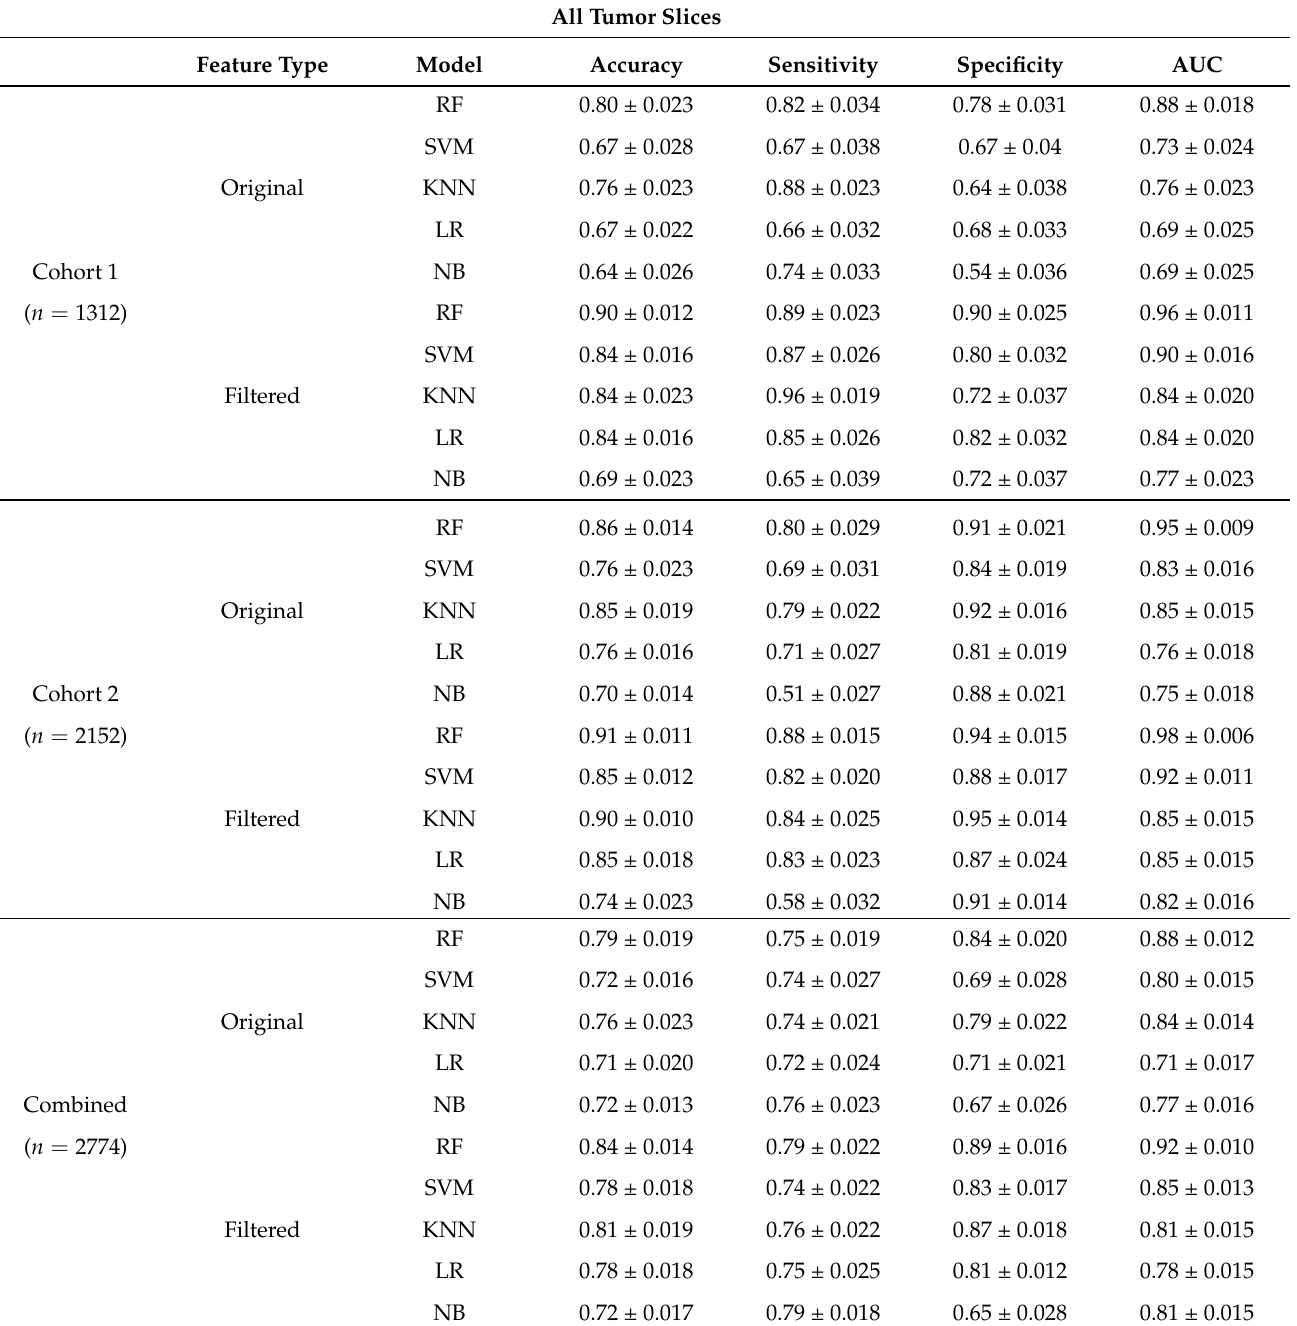
Table 8. Representation of diagnostic performance using all tumor slices for different